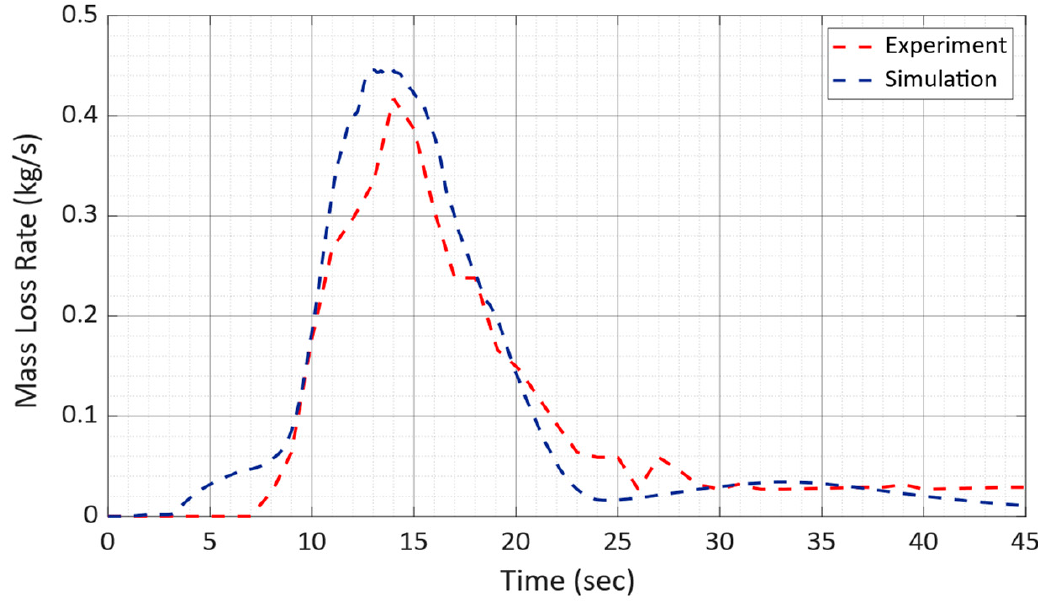
Figure 7. MLR comparison of experiment and FDS simulation using 50 mm grid. The shapes of the two curves are reasonably similar. Simulation results show higher total mass loss than the experiment during the simulation time of 45 s.